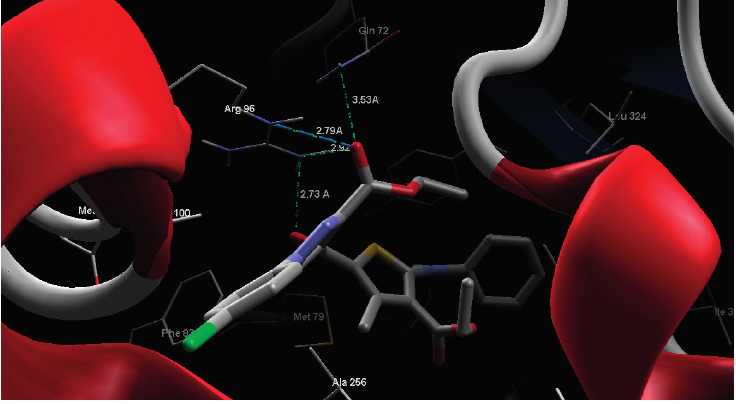
Figure 5. Interaction of compound 9b with the active site of cytochrome P450 14 α -sterol